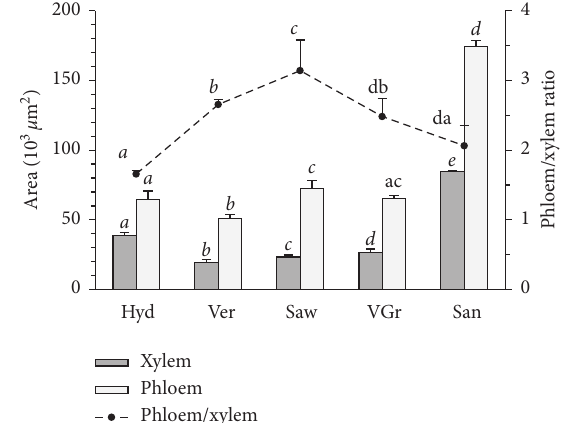
Figure 4: Phloem and xylem characteristics of the cedar main root. Letters indicate significant differences ( P < 0 . 05 LSD test). The acronyms of media are as designated as in Table 1.